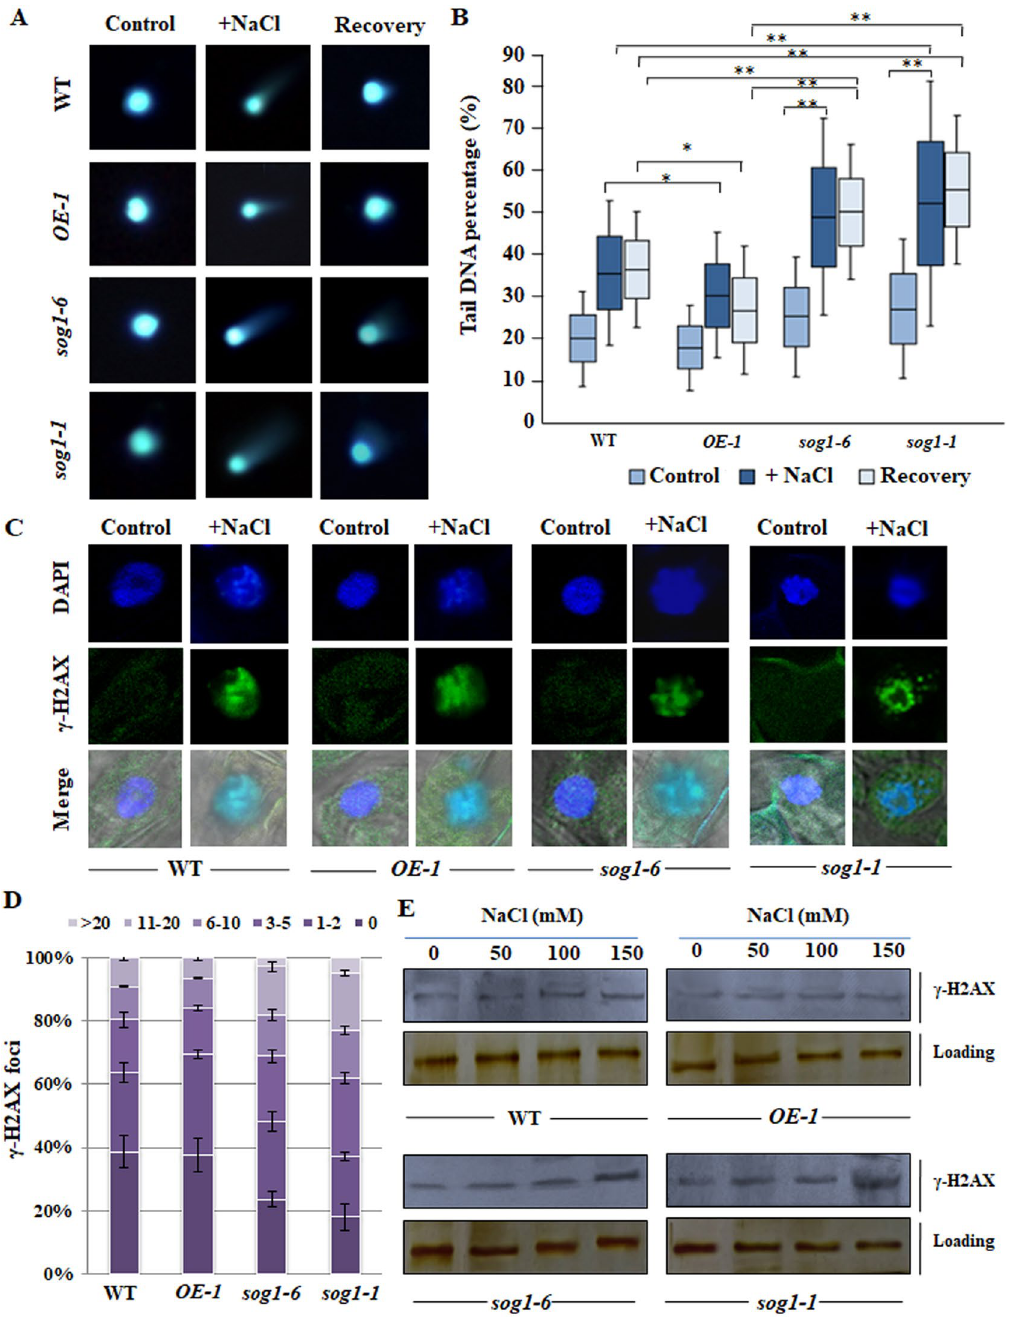
Figure 3. Salinity induced accumulation of DSBs. ( A ) Representative Comet images of 7-days old wild-type, OE-1 , sog1-6 and sog1-1 mutant plants incubated without NaCl for 1 h (control) and incubated with 150 mM NaCl for 12 h and then transferred to medium without NaCl for 5 h (recovery) (left, middle and right panel respectively). ( B ) Box plot of percentages of tail DNA of 7-days old wild-type, OE-1 , sog1-6 and sog1-1 mutant plants. DNA percentage in the comet tails were determined by using TriTek Comet Score software. Box plots are based on analysis of approximately 100 cells per experimental sample from random microscopic fields of three independent biological replicates. Each box represents the interquartile range (IQR) of DNA damage, the line across each box represents the median value and the whiskers represent 5–95 percentile values. Brackets connect box plots of sample groups with significant statistical difference (* p < 0.05, ** p < 0.01). ( C ) Immunostaining of γ-H2AX foci in the root cells of wild-type, overexpressor line and mutant line plants after 12 h of treatment without and with 150 mM NaCl, respectively. ( D ) Counted numbers of γ-H2AX foci per cell detected after 12 h of treatment with 150 mM NaCl in plants of all the genotypes. According to their number of γ-H2AX foci, approximately 100 nuclei for each sample were grouped into six classes; cell with 0, 1–2, 3–5, 6–10, 11–20 and > 20 foci per nuclei. ( E ) Detection of γ-H2AX accumulation by immunoblot analysis using the total histone protein isolated from untreated and NaCl treated of 7-days old wild-type, OE-1 , sog1-6 and sog1-1 mutant plants, respectively. The blots were cut prior to incubation with the primary antibody. Replicates of the protein gel blots have been presented in Supplementary Fig.